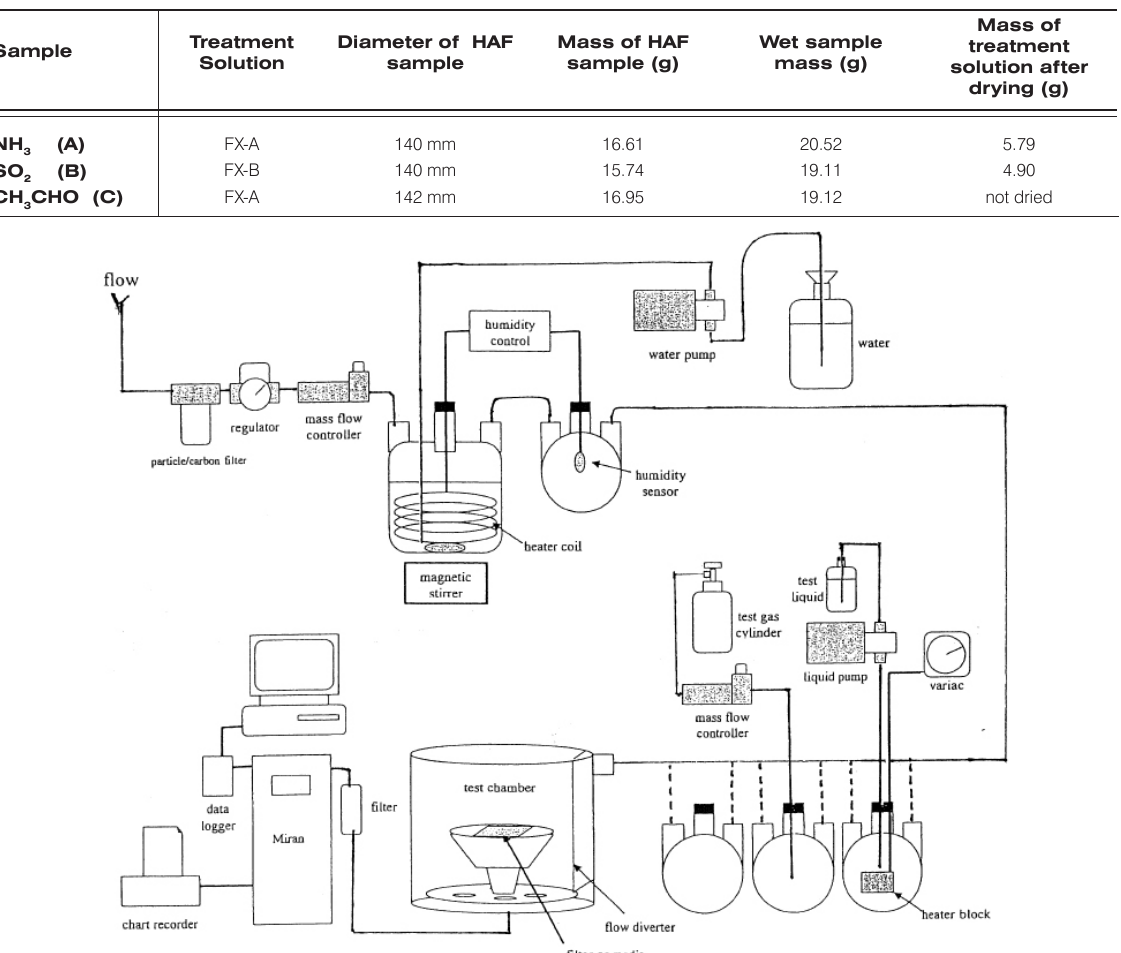
Figure 1. Test apparatus for “Indoor Air” part.